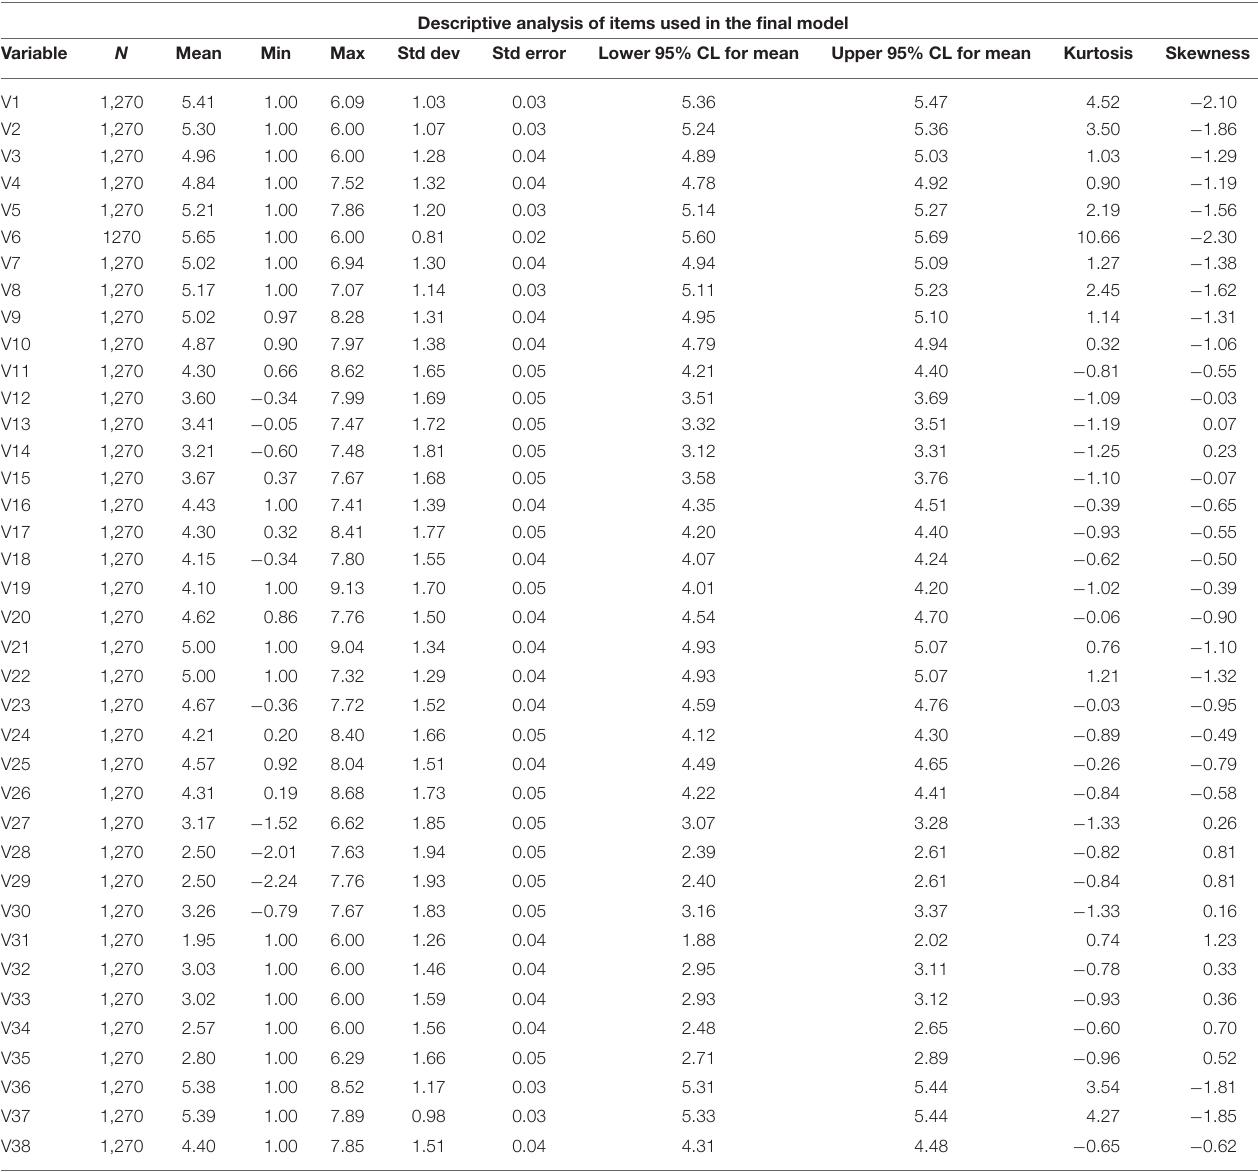
TABLE 2 | Descriptive statistics of items used in the final structural equation model with four latent factors to describe pet owners’ perception of the communication with their veterinarian. Descriptive analysis of items used in the final